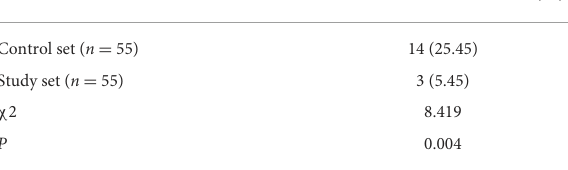
TABLE 2 Contrast of blood infection rates between the two sets of